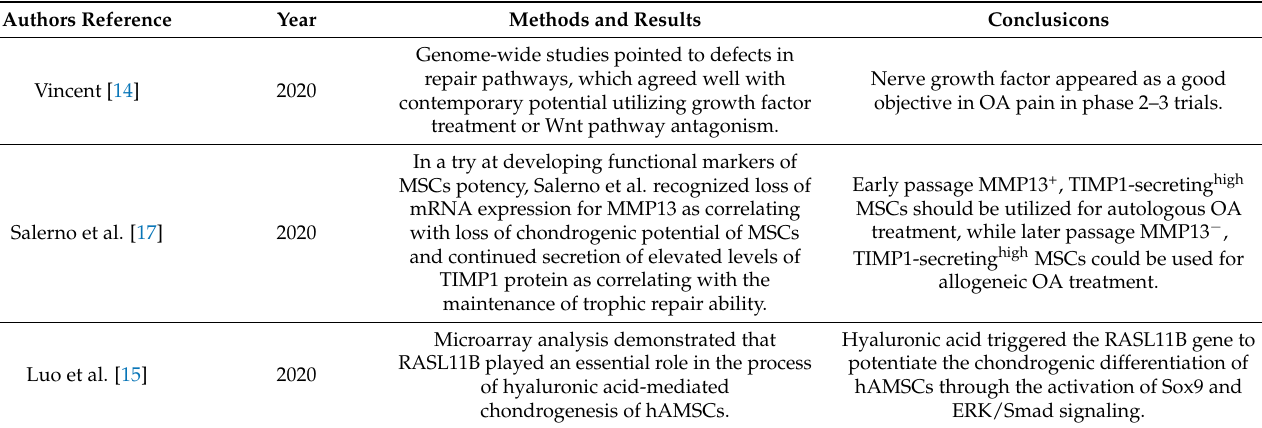
Table 1. Main data from the literature on molecular processes of cartilage repair and their potential clinical